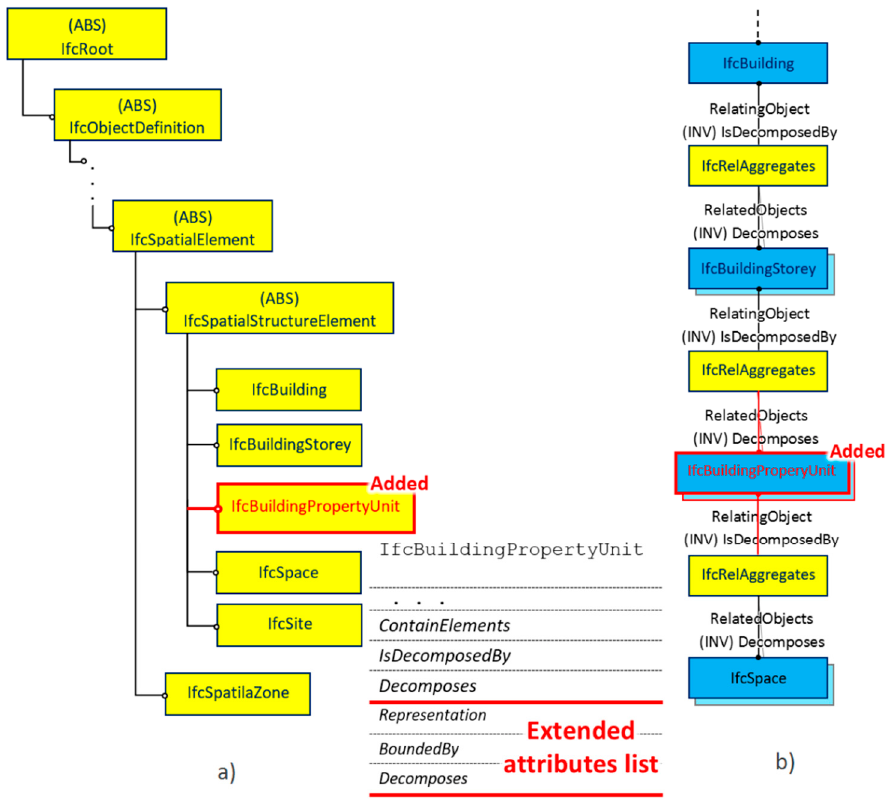
Figure 4. ( a ) The IfcBuildingPropertyUnit in the diagram of inheritance; ( b ) the IfcBuildingPropertyUnit in the decomposition diagram.